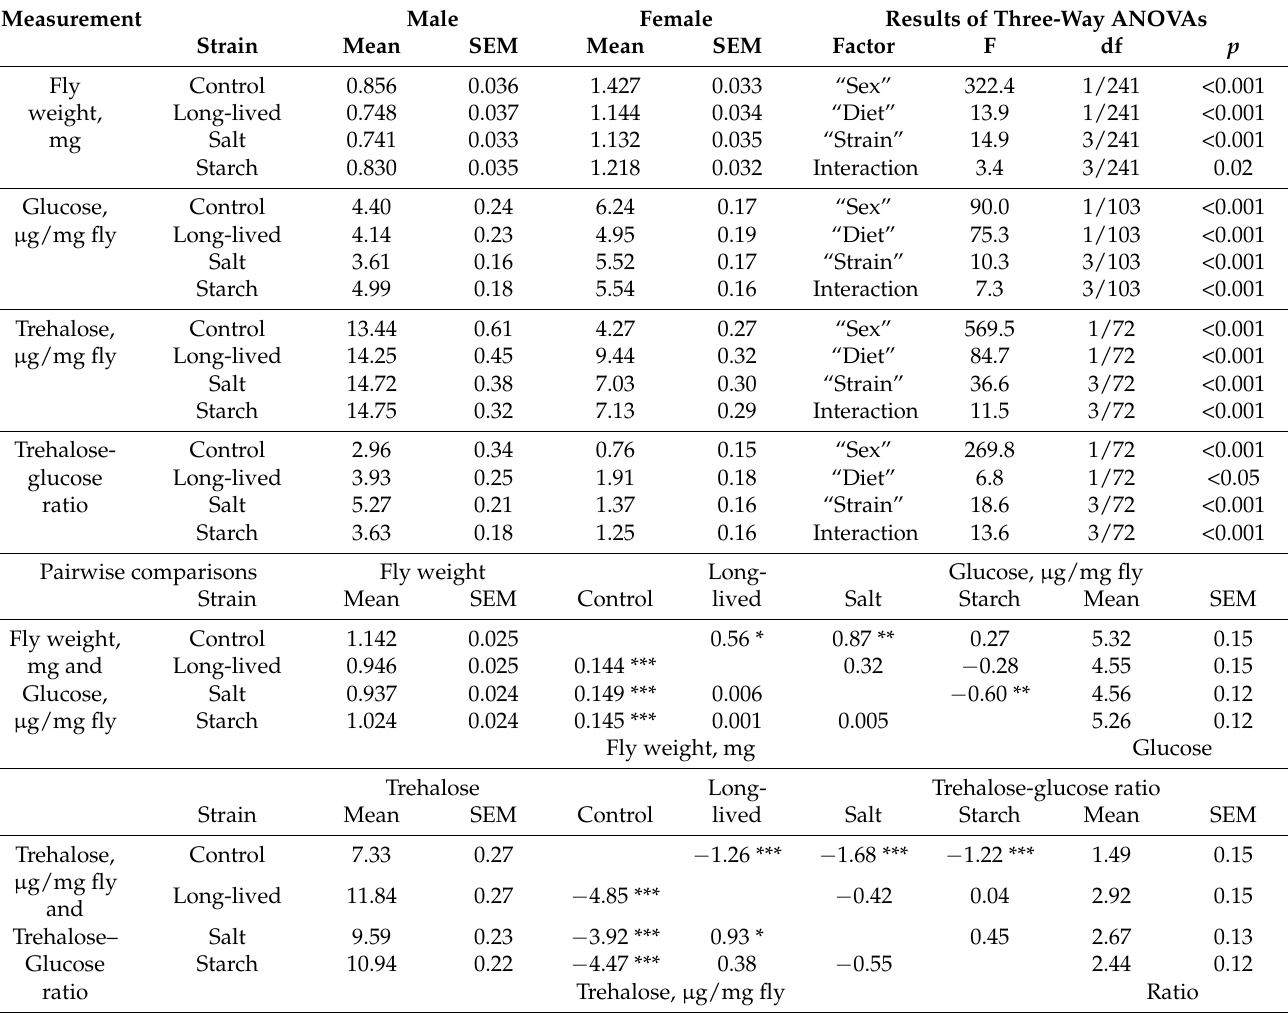
Table 3. Results of three-way ANOVAs of fly weight and two main inset